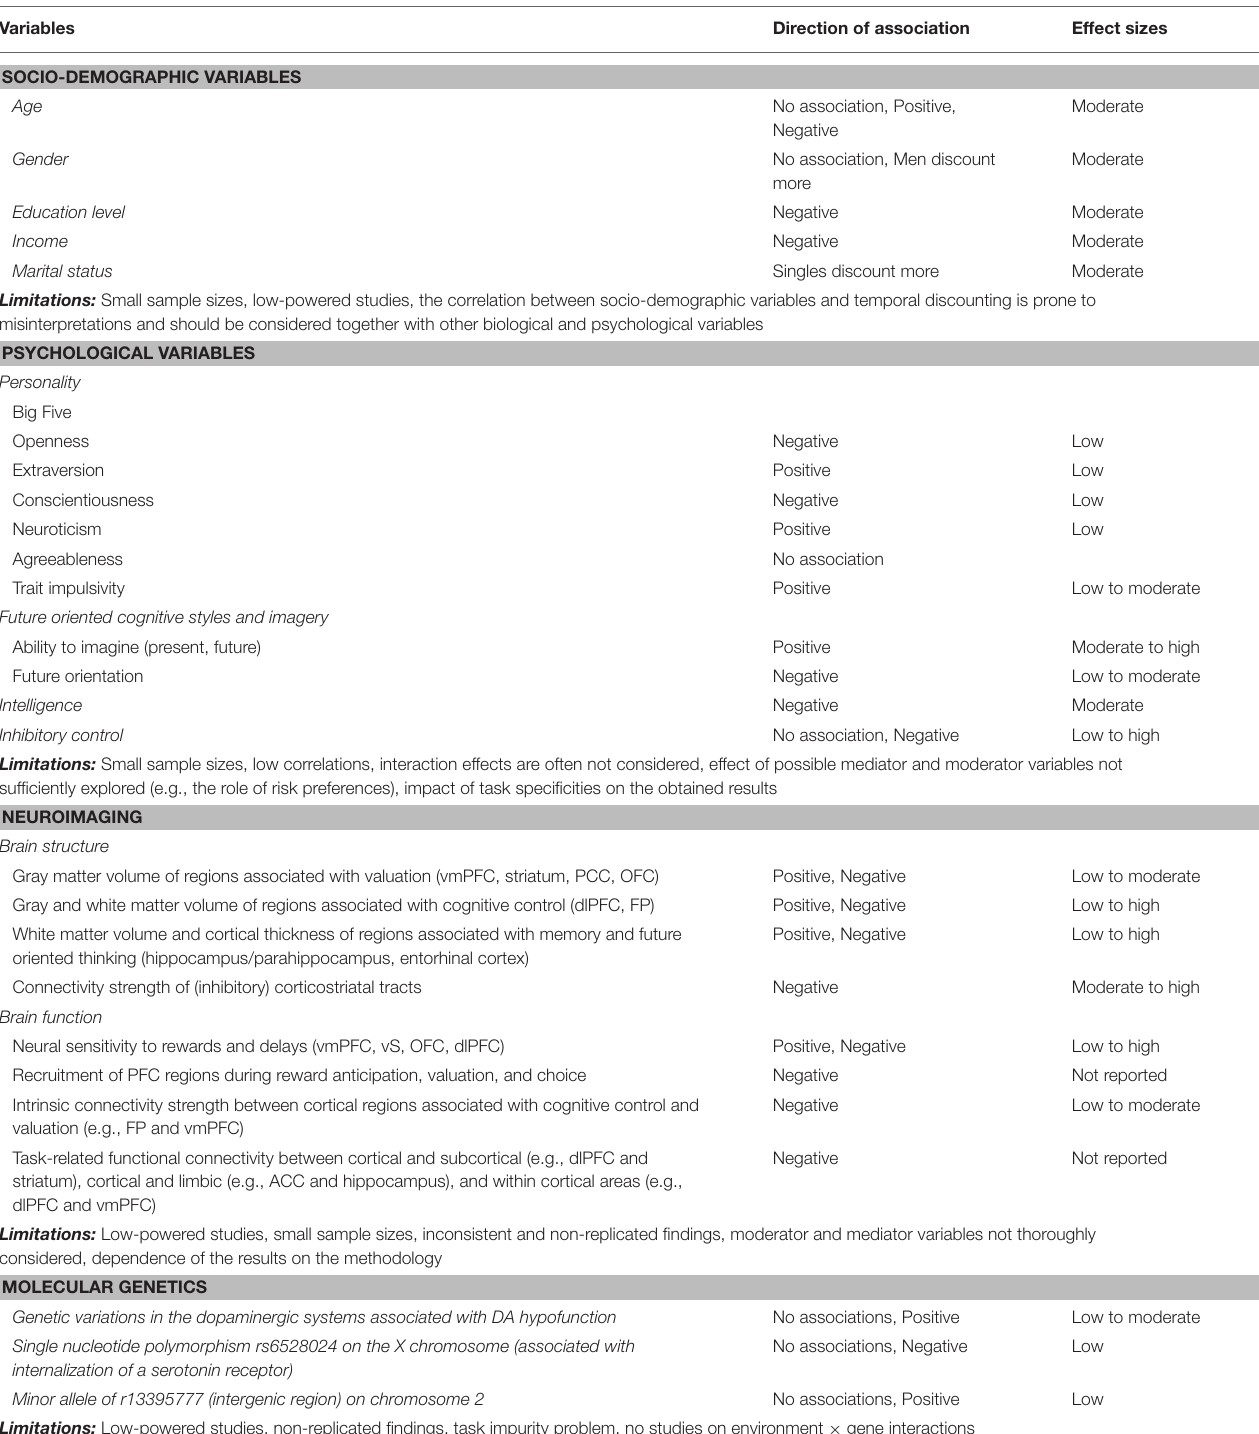
TABLE 1 | Summary of the associations between temporal discounting and socio-demographic, psychological, neuroimaging, and molecular genetic